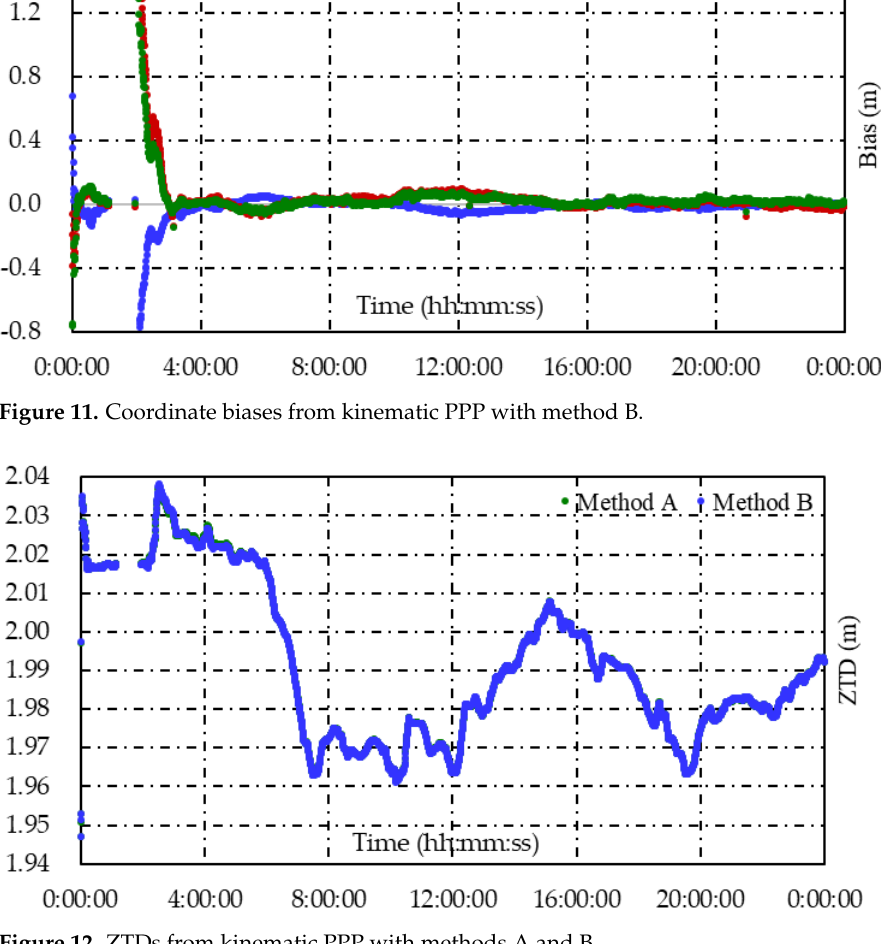
Figure 13. dSION between method B and A from kinematic PPP with various satellites. 3.3. Validation for Type II Clock Jump Solution For this case, the aforementioned site PIXI is selected. On 12 May 2008, the site suf- fered an earthquake of magnitude 8.0, and it was about 48 kilometers far from the epicen- ter. In the case of earthquake alarm application, PIXI receives the GPS signal at 1s inter- vals. After examining the PIXI observation, it can be found that the pseudo ranges suffered from ms jump (MSJP) every 674 s, but the carrier phase is smooth, and the observation data are interrupted by a power outage due to the big earthquake, and the last time to record observation is at 6:29:10 (GPS time, the same as the following), and the earthquake happened at 6:28:17, so there was about 1 min to capture the kinematic deformation de- spite the earthquake lasting 80~120 s. At this time, the IGS final orbit and clock are used as the PPP datum. From Figure 14, it is clear to see the MSJP in the time series. An MW arc of G02 is shown in Figure 15; unlike in Figure 6, this MW has a jump every 674 s . If unaltered, corresponding ambiguities under this clock jumps of type II will be reinitial- ized about every 11 min, and of course the accuracy of all parameters will be seriously degraded since it cannot benefit from the accurate ambiguities in this situation.